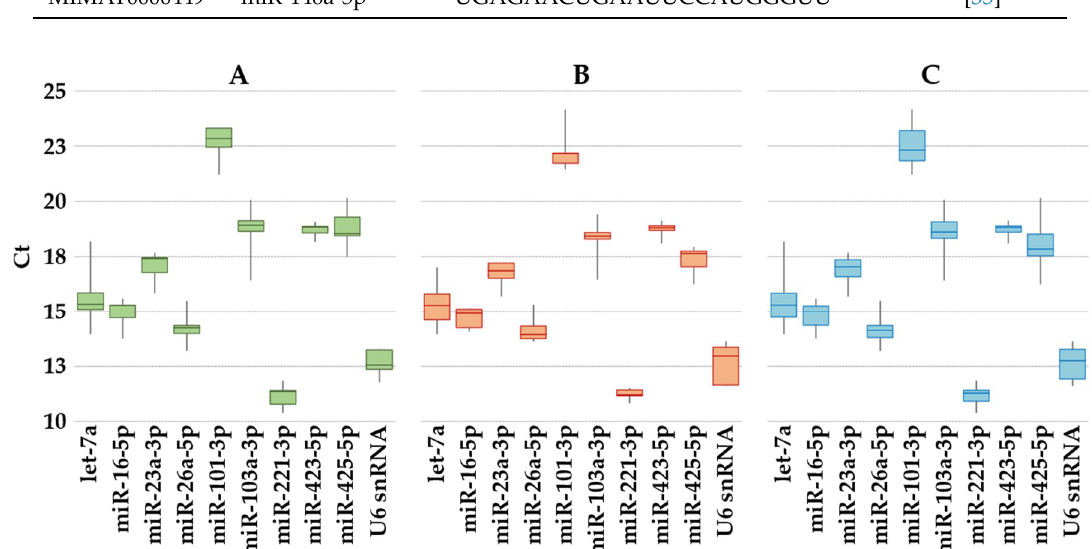
Figure 2. Expression of candidate reference genes in ASC-EVs. The box plot graphs of the Ct values for each reference gene illustrate the interquartile range (box) and median. The whisker plot depicts the range of the values. ( A ) ASC without priming; ( B ) ASC after inflammatory stimuli; ( C ) All the studied samples.